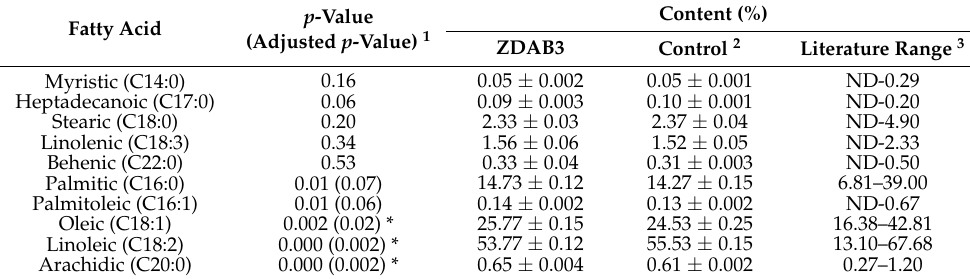
Table 4. Fatty acid values in maize